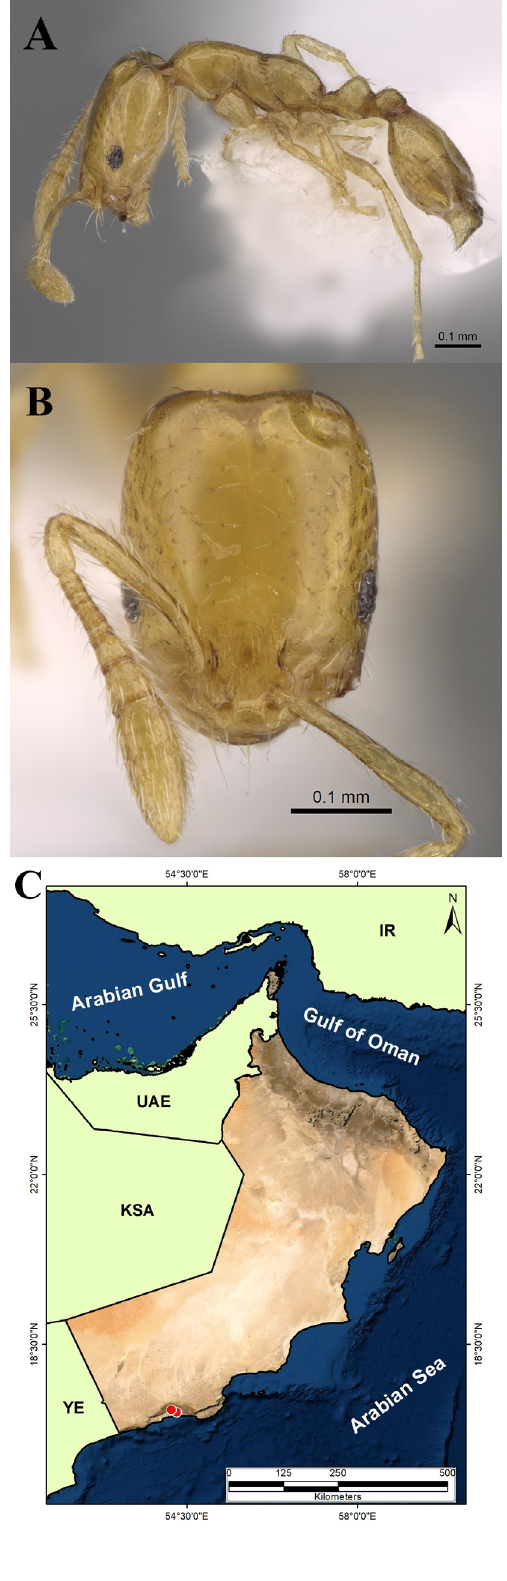
Fig. 37. Monomorium clavicorne André, 1881, major worker (CASENT0922879, AntWeb.org (Michele Esposito)). A . Body in profile. B . Head in full-face view. C . Distribution